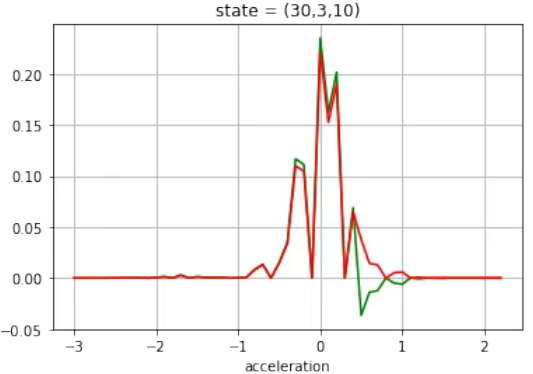
Figure 6. The ESC of state = (30,3,10) using HighD.